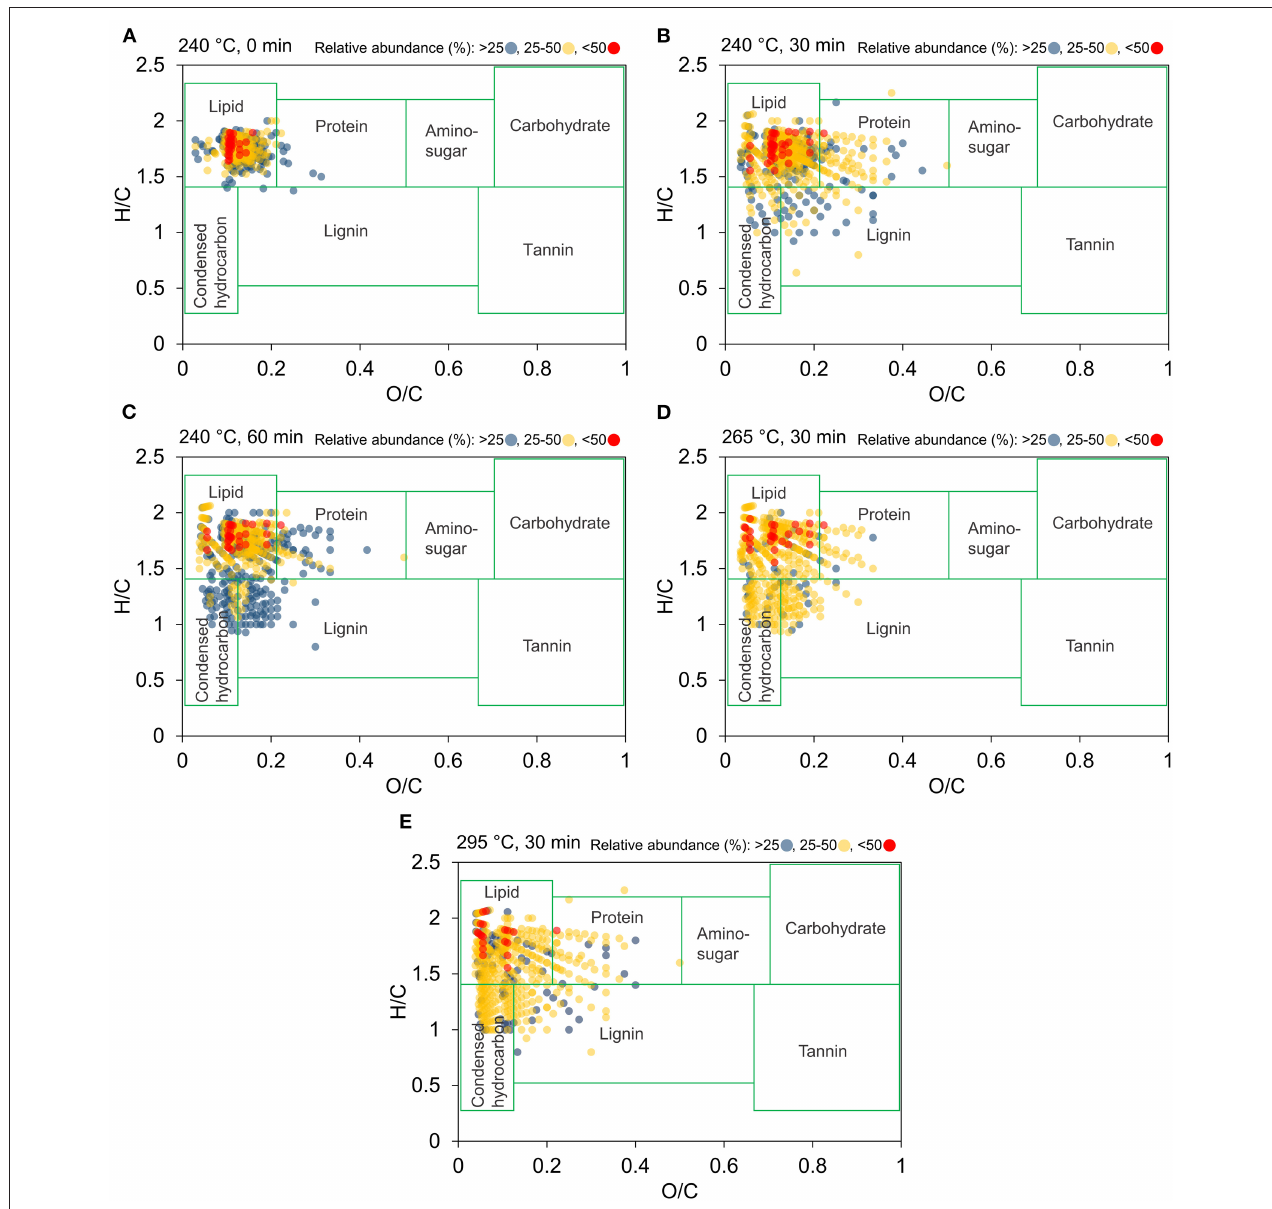
FIGURE 8 | Van Krevelen diagrams for bio-crude oil obtained from (A) 240 ◦ C, 0min, (B) 240 ◦ C, 30min, (C) 240 ◦ C, 60min, (D) 265 ◦ C, 30min, and (E) 295 ◦ C, 30min based on data derived from positive-ions APPI FT-ICR MS. The relative abundance is represented by blue circles ( < 25%), yellow circles (25–50%), and red circles ( >